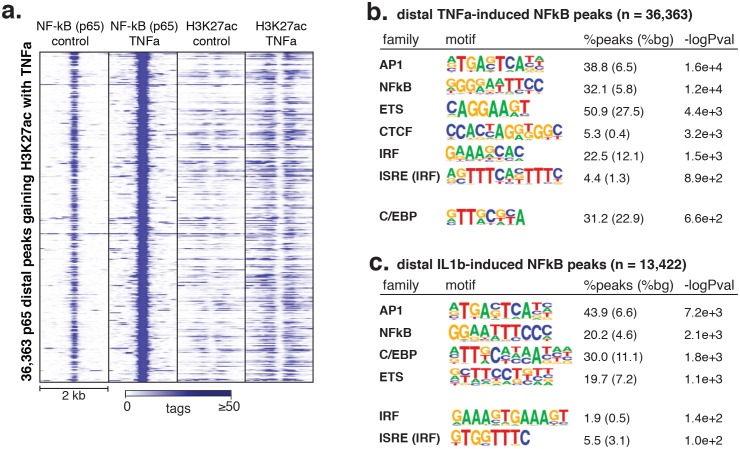
Signal-responsive transcription factor NFκB binds endothelial enhancers.(a) The heme oxygenase 1 (HMOX1) and thioredoxin reductase 1 (TXNRD1) loci are co-bound by ERG, JUN and NRF2 and accumulate H3K27ac upon 4-hr oxPAPC treatment. (b) NRF2 binding was measured by ChIP-seq after 4-hr oxPAPC treatment and coincides with increased H3K27ac on adjacent nucleosomes. (c) The top most enriched motifs at NRF2 peaks. (d) NF-κB component p65 ChIP-seq identified 36,363 distal loci that largely gained H3K27ac upon TNFα treatment. (e–f) Top enriched motifs at distal TNFα-induced (e) and IL1β-induced (f) p65-bound loci.